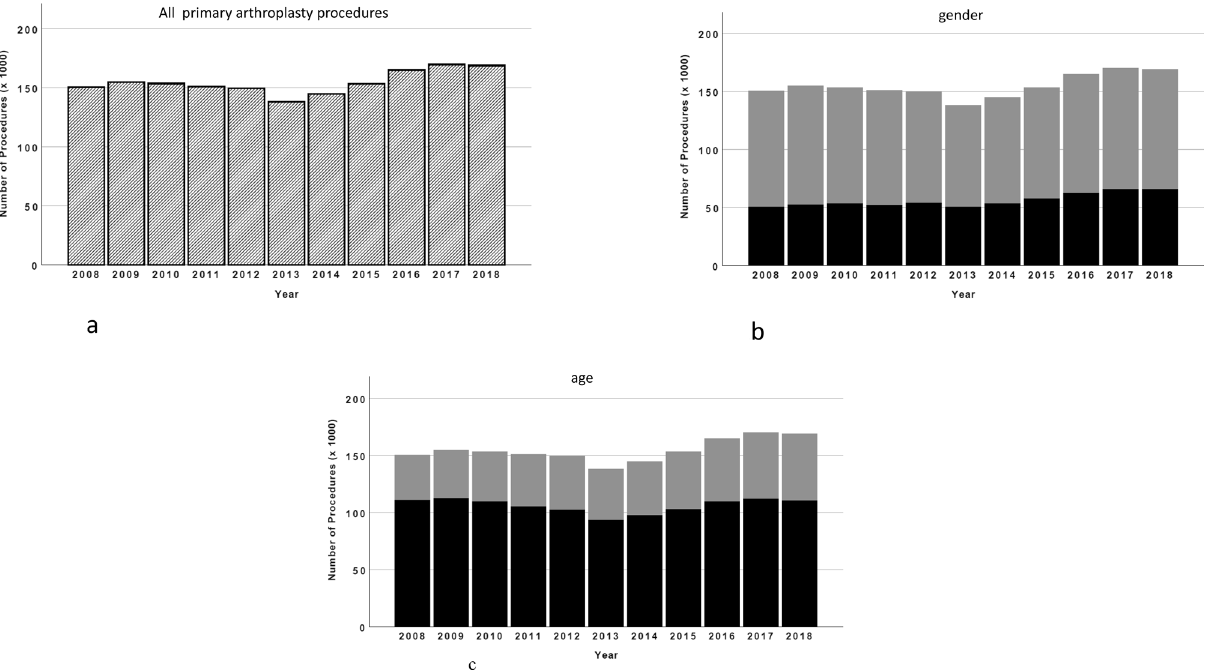
Figure 1. ( a ) All performed primary knee arthroplasty procedures from 2008 to 2018. ( b ) All performed primary knee arthroplasty procedures from 2008 to 2018, with regard on the gender of patients (grey = female; black = male). ( c ) All performed primary knee arthroplasty procedures from 2008 to 2018, with regard on the age of patients (grey: < 65 years; black ≥ 65 years).